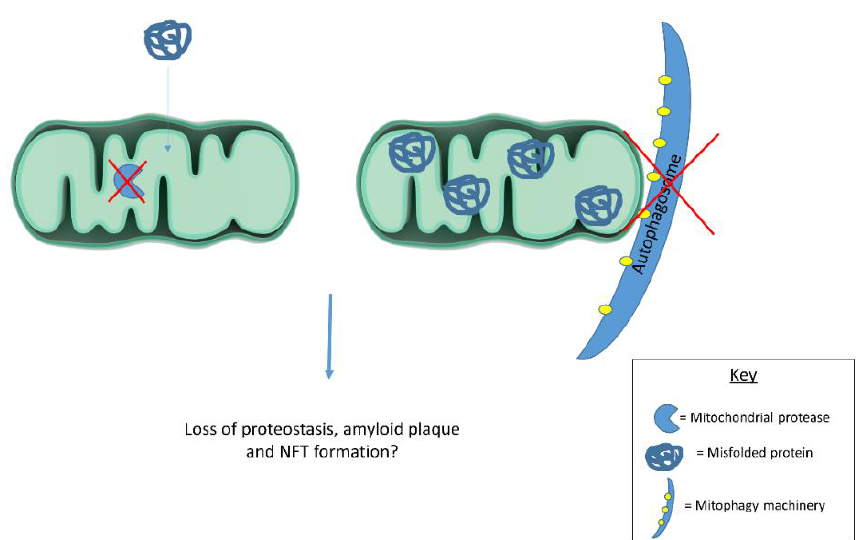
Figure 1. Mitochondrial proteases and mitophagy contribute to cellular proteostasis. Dysfunctional proteases and/or mitophagy could contribute to protein misfolding in disease states. Future work should examine mitochondrial contributions to cellular proteostasis in human cells as this process has largely been described in yeast.